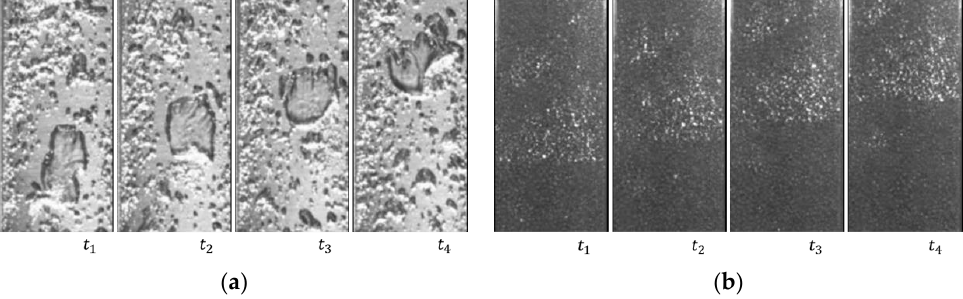
Figure 4. Flow patterns observed from the plain rectangular channel ( a ) and the copper porous media filled channel ( b ) at mean vapor quality are ( a ) = 0.13, ( b ) = 0.12.